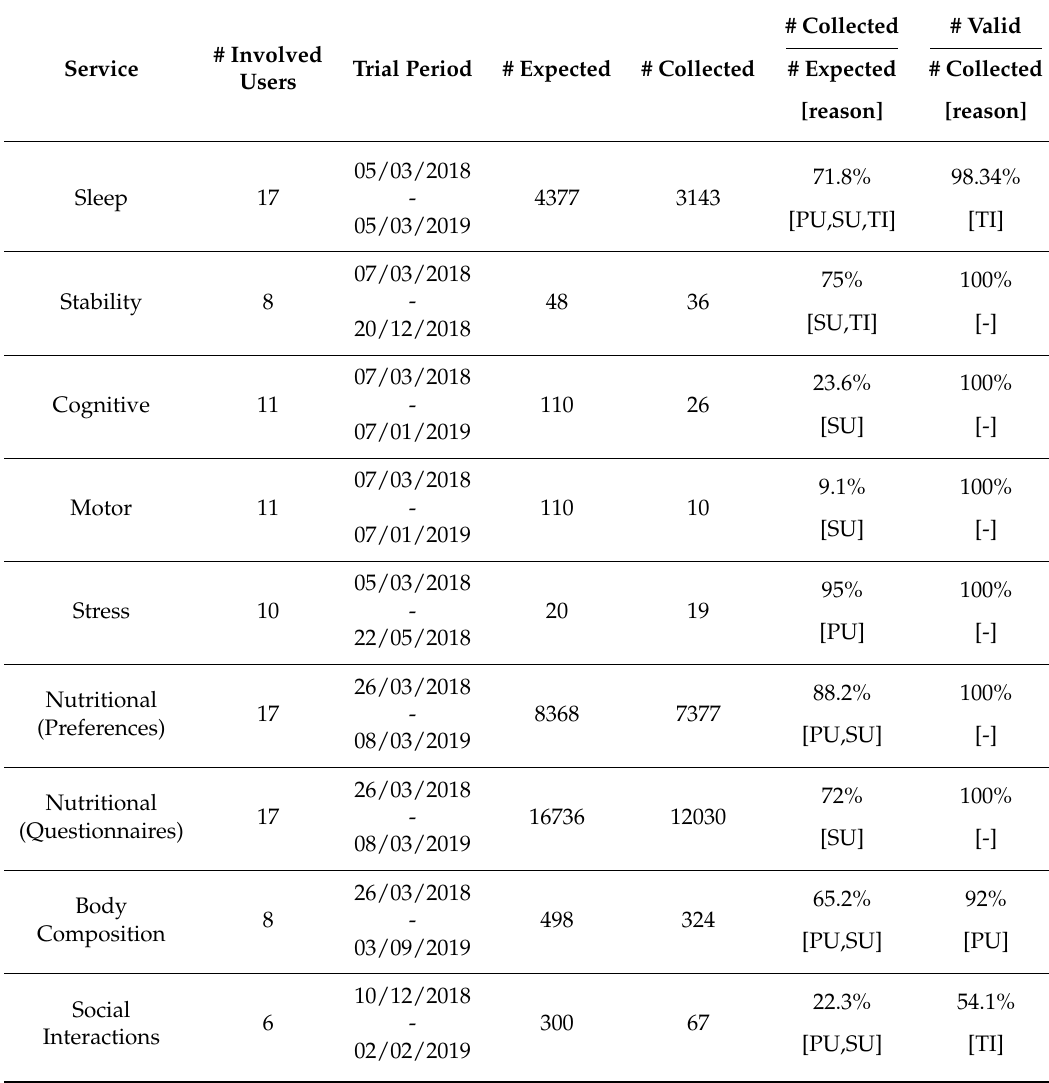
Table 2. Aggregated service statistics within the respective trial periods. For the last two columns, we also show the reasons why the values are not 100% (PU, SU, or